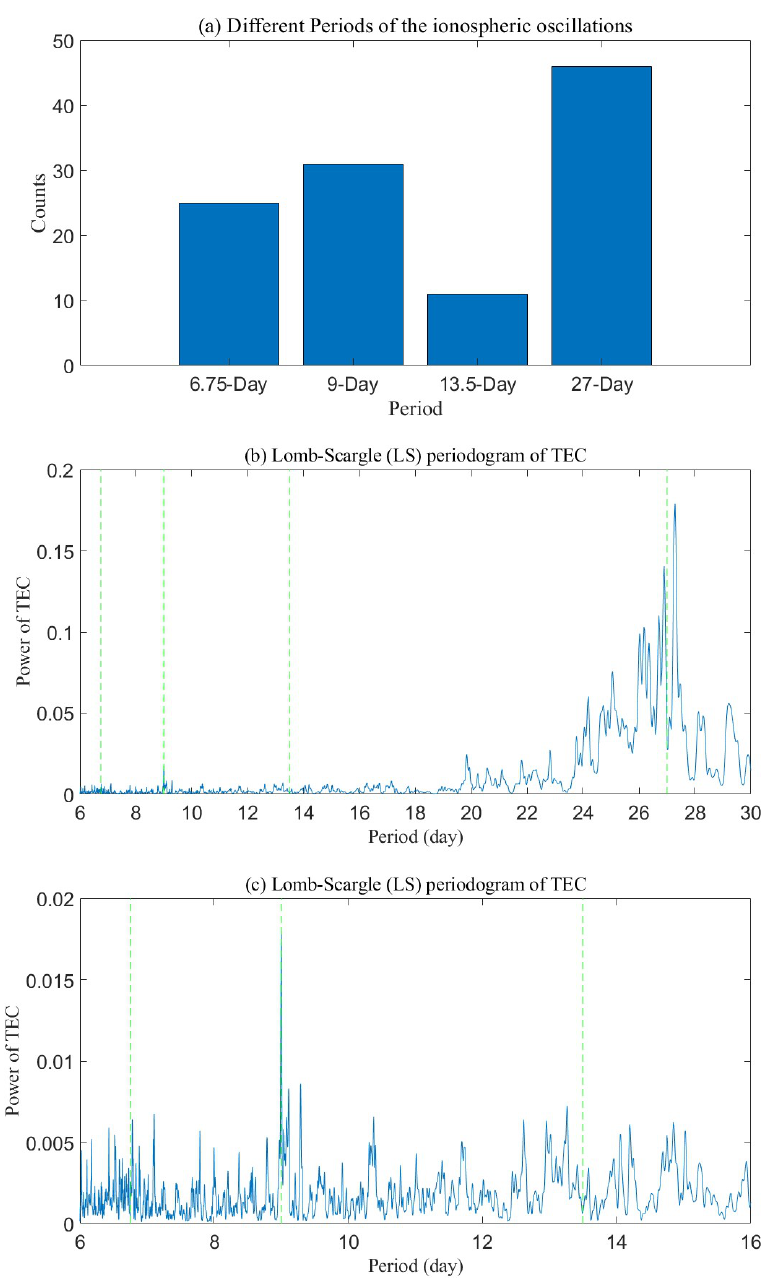
Figure 5. ( a ) Counts of ionospheric oscillations with periods centering at the four harmonic periods of solar rotation. ( b ) The Lomb-Scargle (LS) periodogram of the original IGS-TEC data during 2001–2018 with a period range of 6–30 days. The green vertical dash lines represent the four harmonic periods of solar rotation. ( c ) Same as ( b ), but the period range is 6–16 days.